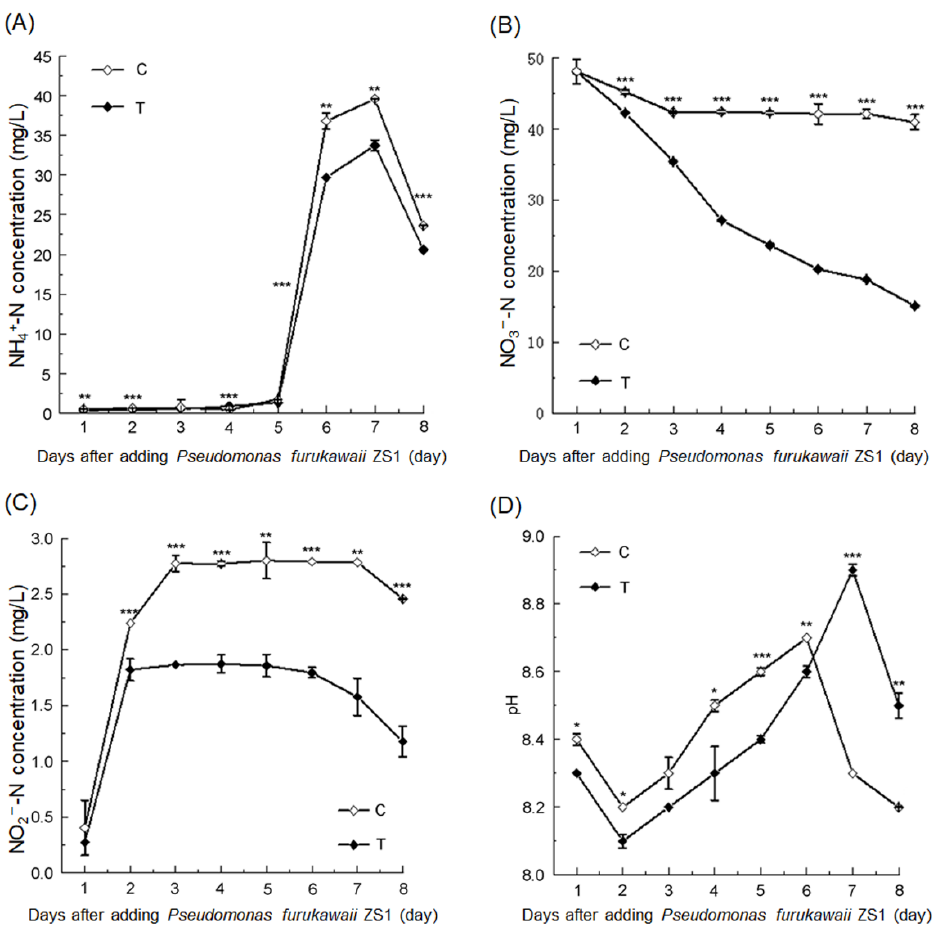
Figure 1. Changes in ammonia nitrogen ( A ), nitrate ( B ), and nitrite ( C ) concentrations, as well as in pH ( D ) in tested water samples during the experimental process. The treatment group contained added Pseudomonas furukawaii ZS1. *, p < 0.05; **, p < 0.01; ***, p < 0.001.